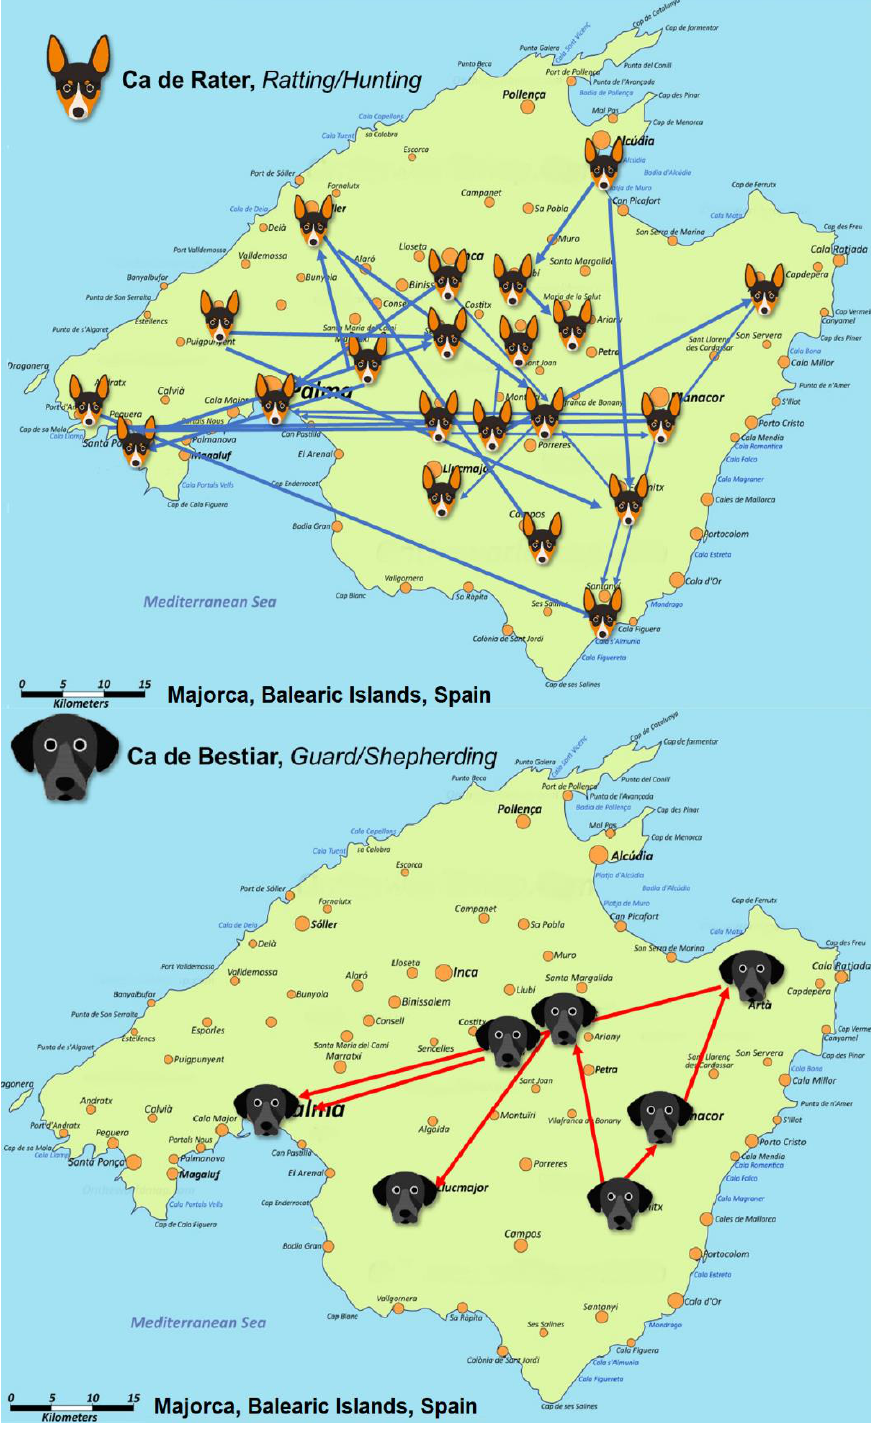
Figure 3. Breeder location connection maps for Ca de Rater and Ca de Bestiar breeds.